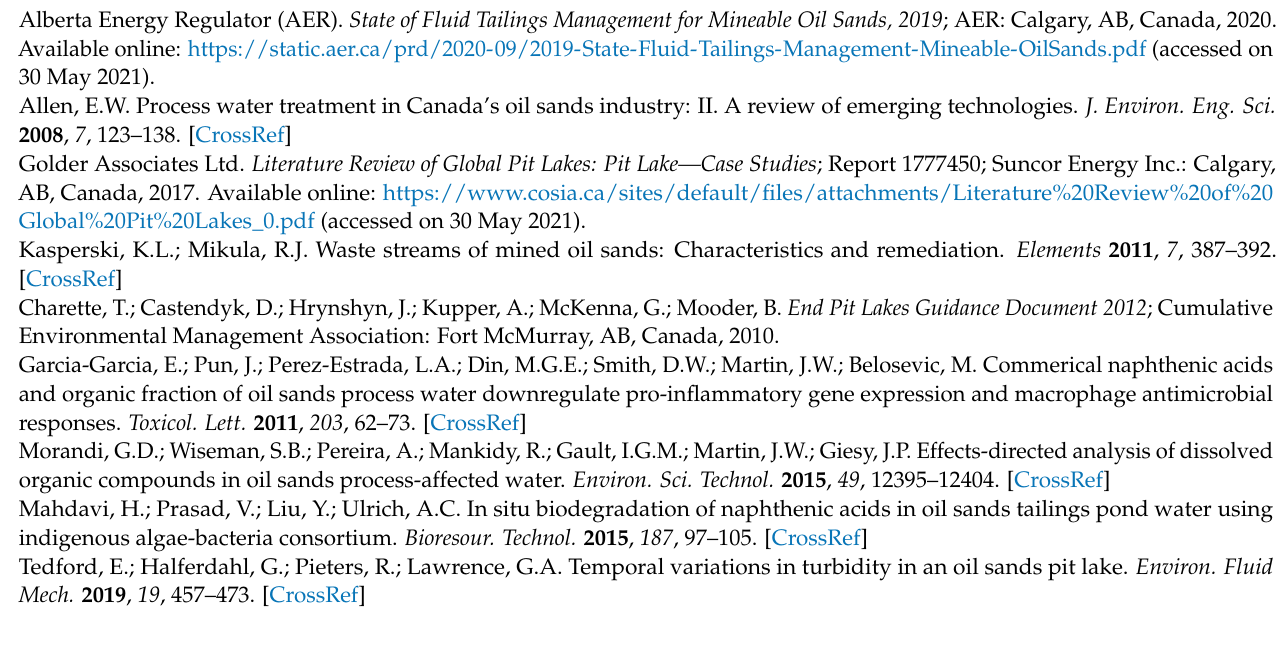
Figure S1: Picture of Biofilm10 and Biofilm20 jars; Figure S2: Picture of A: Gas bubble in a Biofilm 20 jar and B: Lifting and layering of Biofilm20 following gas bubble release; Figure S3: Comparison